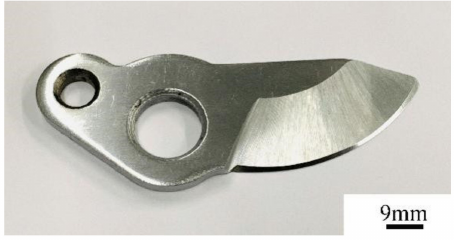
Figure 1. SK-5 High-carbon steel pruner. Table 1. Chemical component of SK-5 high-carbon steel.